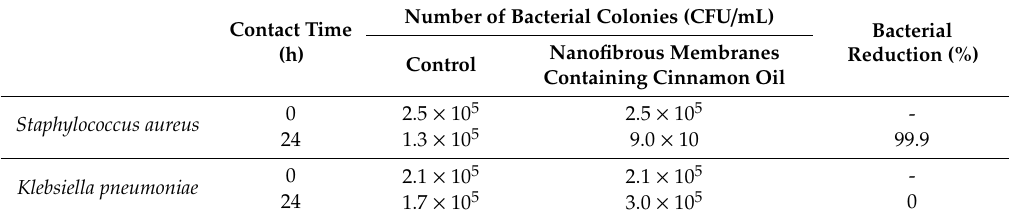
Table 5. Antibacterial e ff ects of nanofibrous membranes containing cinnamon oil against Staphylococcus aureus and Klebsiella